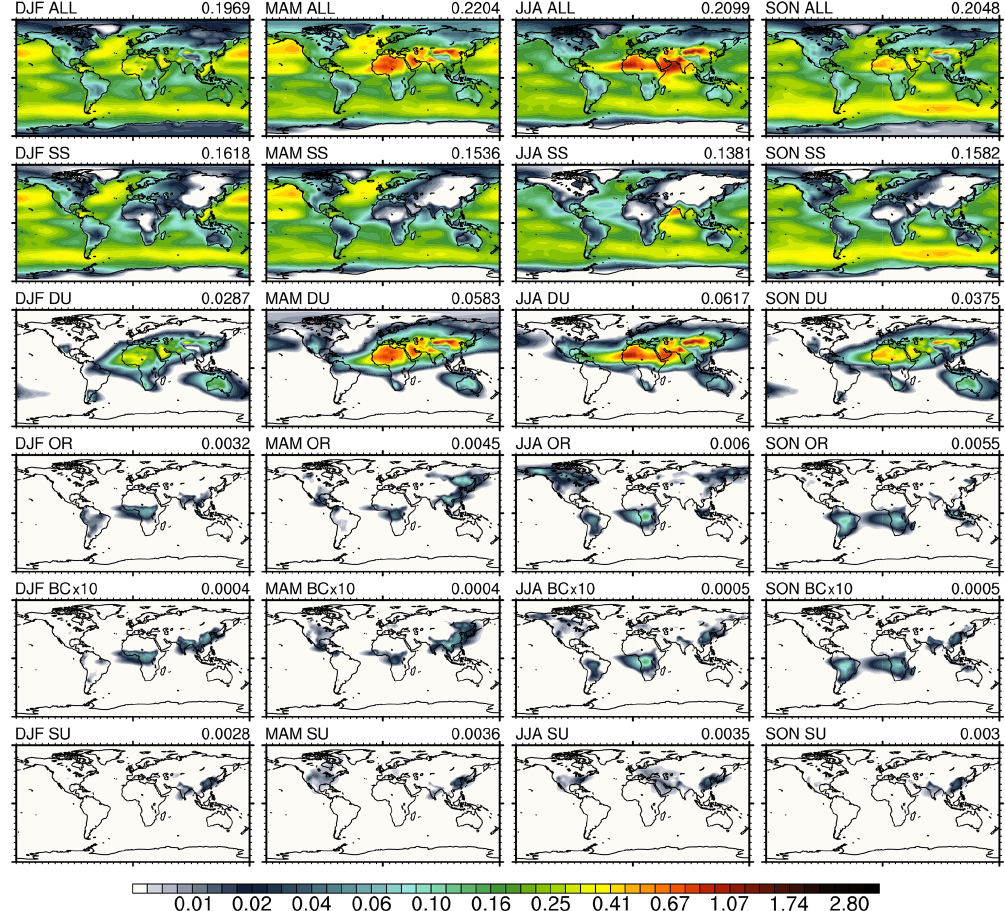
Figure 1. Seasonal vertically integrated aerosol mass (in grams per square metre) from the CAMS Interim reanalysis control run, scaled to conserve the total AOT of the assimilation run. The top row shows the total integrated mass for all aerosol types, and the other rows show the contribution from the single species for each season (see text for the abbreviations). Indicated in the top right of each map is the global average. Notice that values for the black carbon type (BC) have been multiplied by 10 for better visualisation, while the global average shows the unscaled